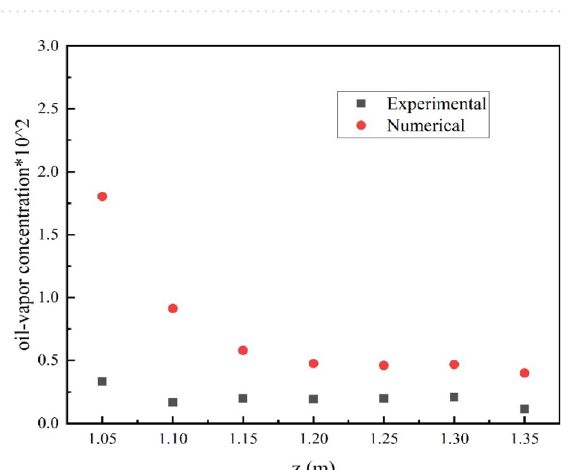
Figure 1. Physical model.